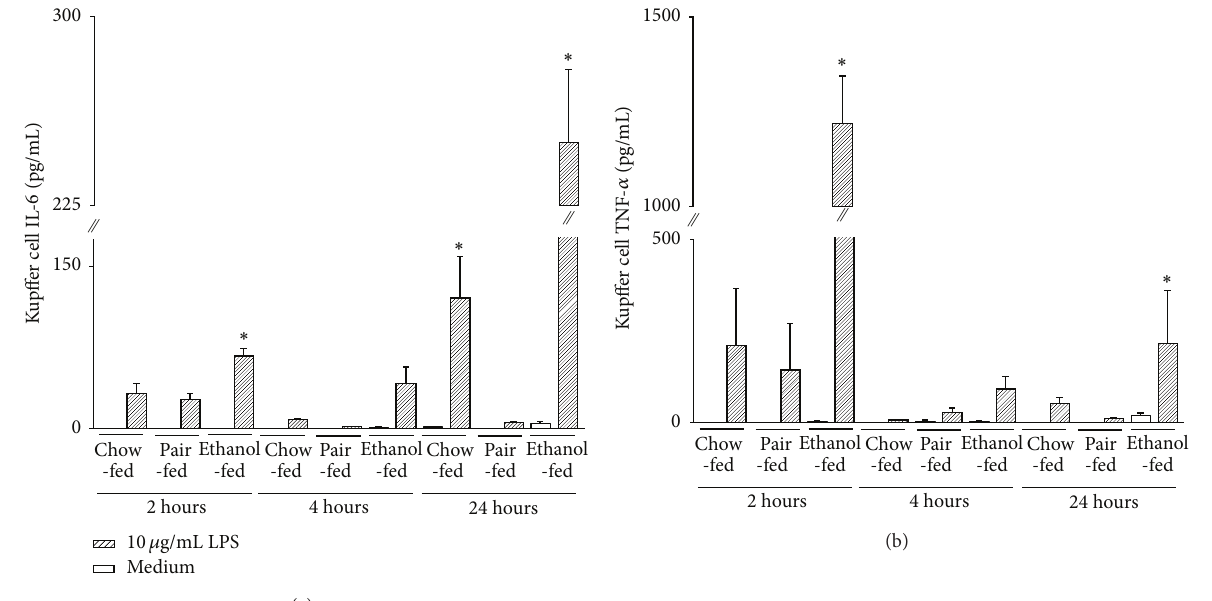
Figure 6: Proinflammatory cytokine production of F4/80 − hepatic macrophages following ethanol feeding in response to LPS or TNF- 𝛼 . Kupffer cells were isolated from cis -NF- 𝜅 B EGFP mice after 4 weeks of pair feeding regime, as described in Section 2, and stimulated with 10 𝜇 g/mL LPS or 500ng/mL TNF- 𝛼 . Culture supernatants were collected at 2 h, 4h, and 24 h after stimulation. IL-6 (a) and TNF- 𝛼 (b) were measured by cytometric bead array (CBA). Data (mean ± SEM) are representative of five to eight independent experiments. ∗ 𝑃 < 0.05 versus